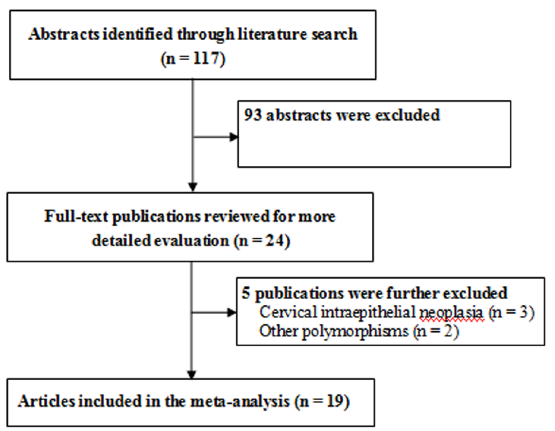
Figure 1. Flow chart of study selection in the meta-analysis of the association between TNF- a rs1800629 polymorphism and cervical lesions risk.